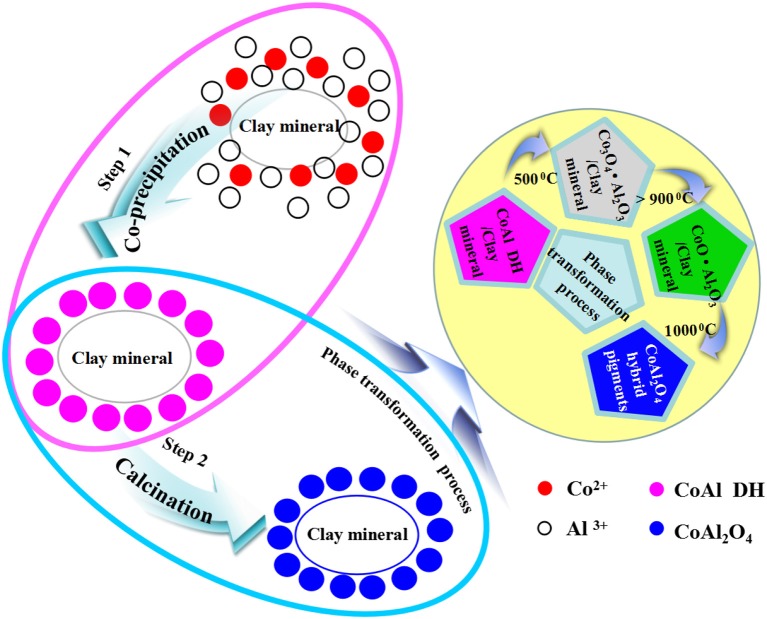
Schematic for Kaol-HP formation process and the relevant phase transformation process during calcining.